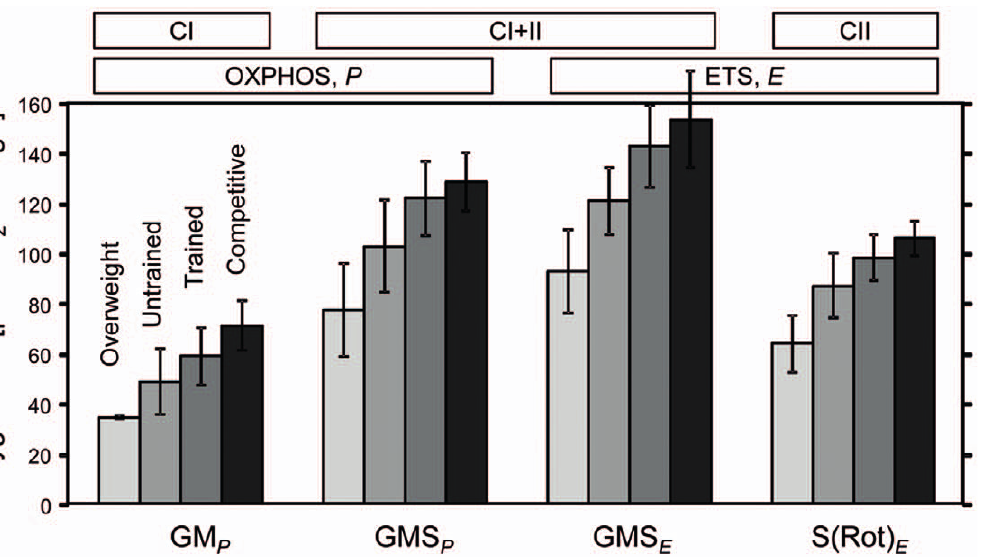
Figure 2. OXPHOS and ETS capacity (pmol ? s 2 1 ? mg 2 1 wet weight) with CI-, CI + II- and CII-substrate supply as a function of physical fitness level (SUIT1 protocol). From light gray to dark gray: overweight-untrained ( N =3) R untrained with optimal body condition score (BCS; N =8) R trained with optimal BCS ( N =16) R competitive with optimal BCS ( N =5); N : number of horses.